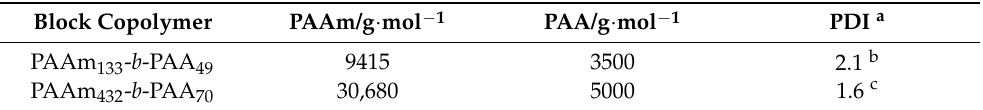
Table 1. Weight average molar mass of the blocks and dispersity (PDI) of the PAAm- b -PAA block copolymers (in the acid forms) employed in this